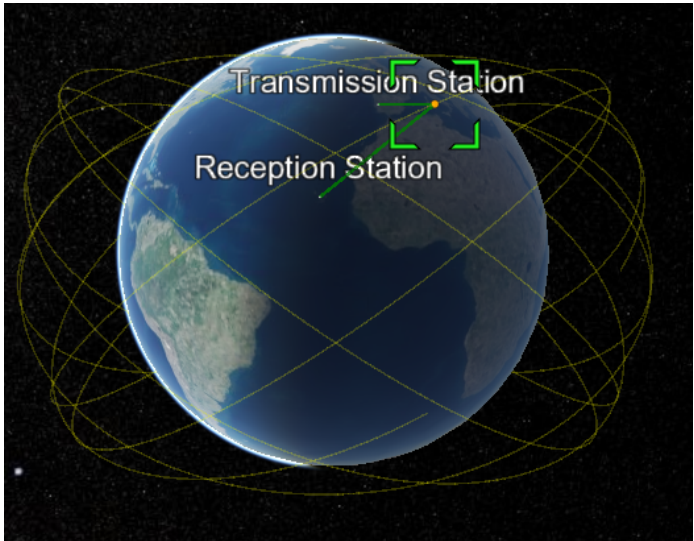
Figure 9. Satellite orbit elements in Cesium